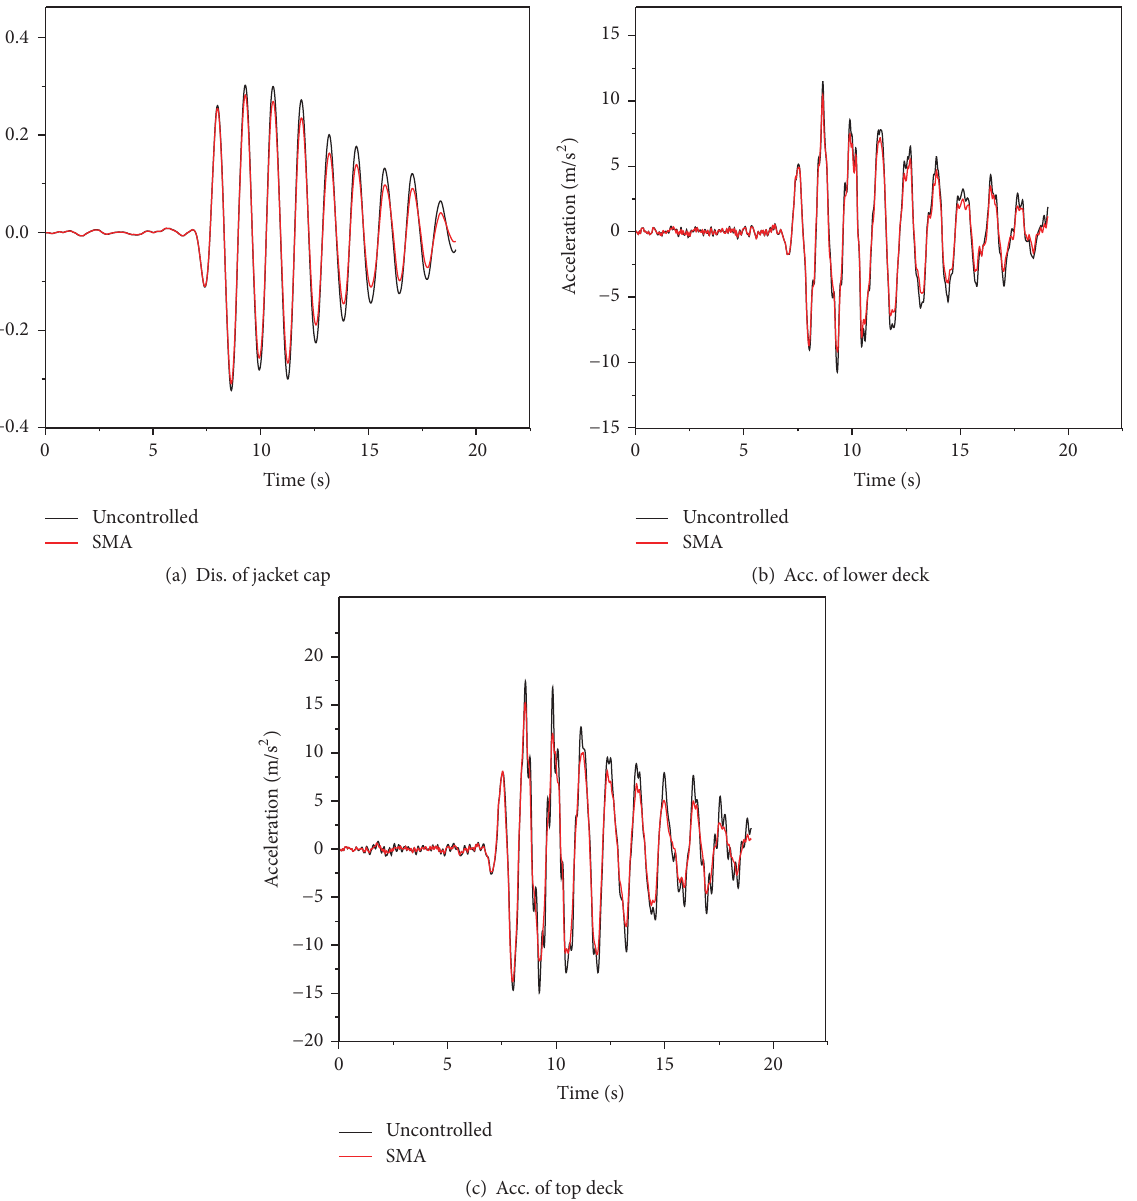
Figure 7: Computational response of JZ20-2MQU model under Tianjin earthquake excitation. Table 3: Maximum test results of earthquake excitation of the platform with SMA